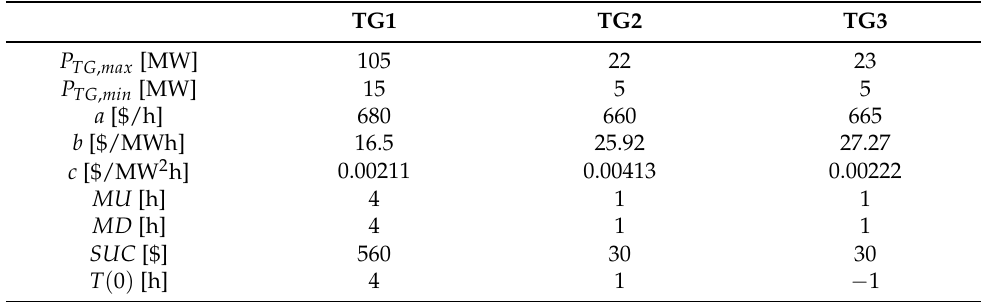
Table 2. Thermal generators data [42,43].